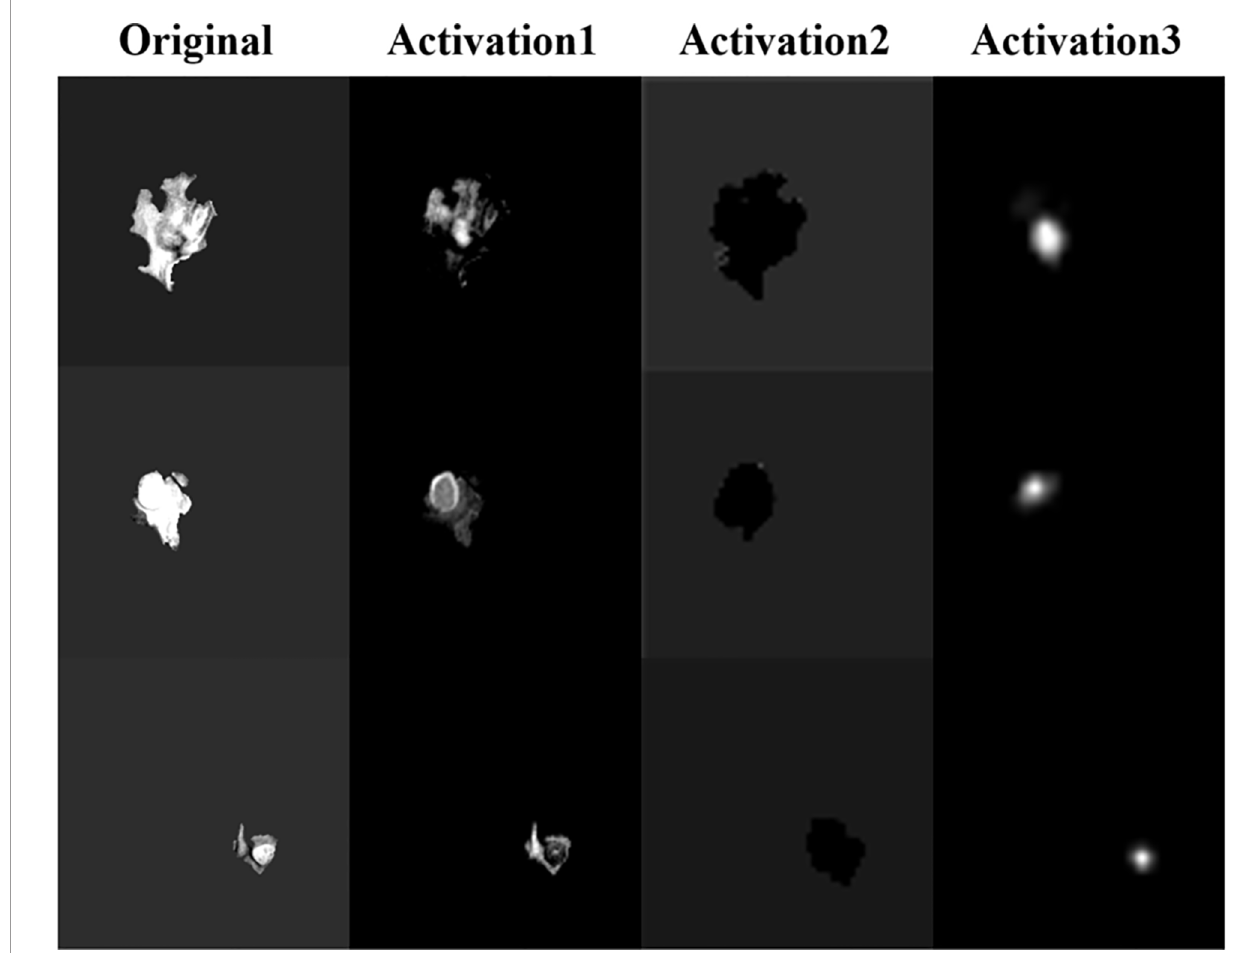
FIGURE 14 | Activation map, the feature map after the ReLU activation layer in the network.